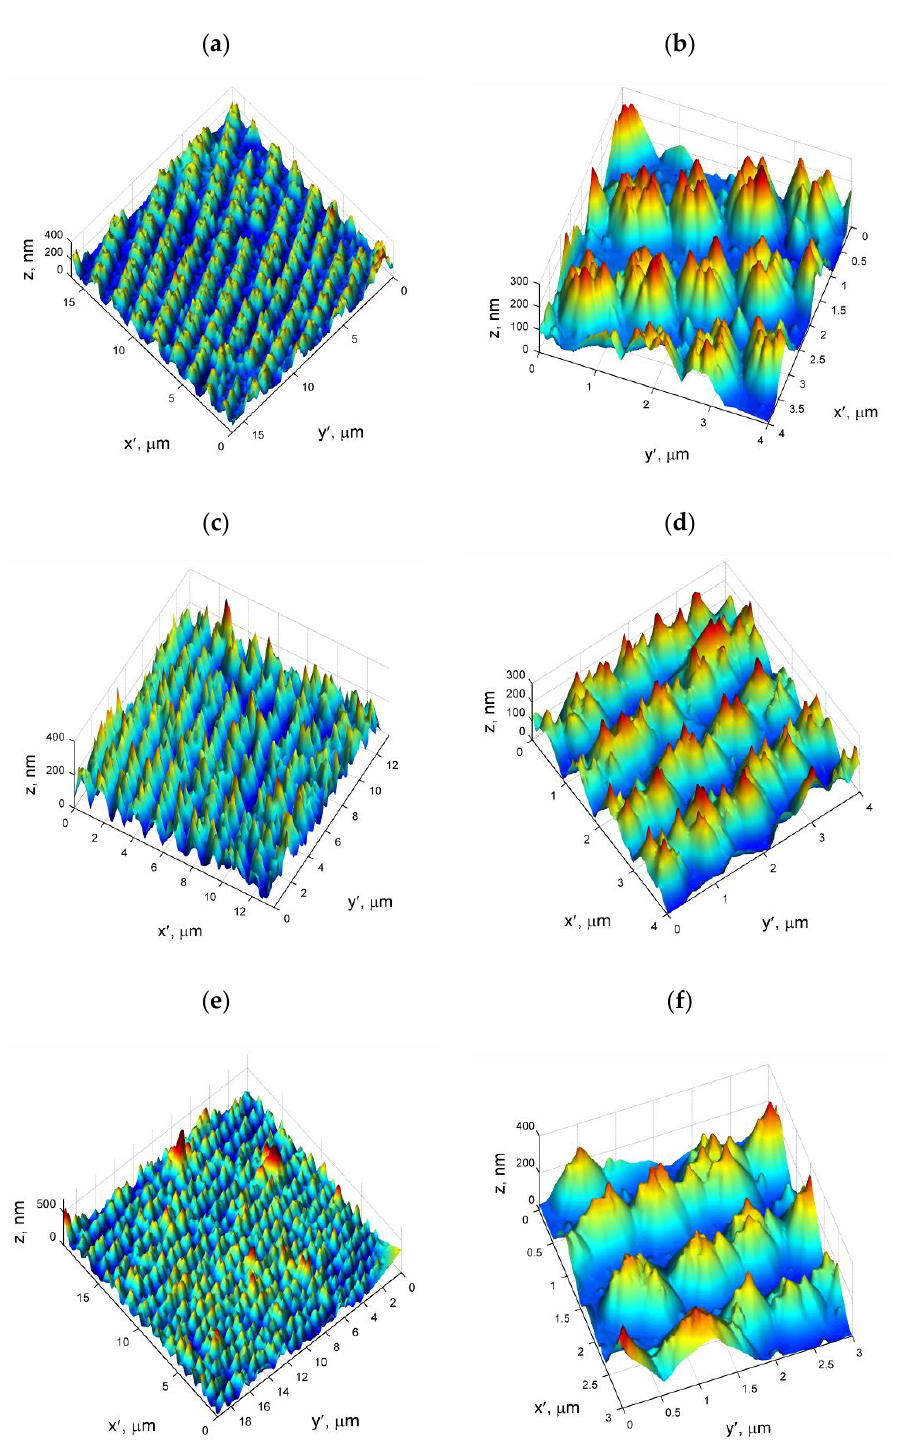
Figure 6. AFM images for patterns with squares arranged according to Scheme B. Above— H = 1 µ m and h y = 1.2 µ m ( U = 5 kV and D = 5000 µ C/cm 2 ), in the middle— H = 0.25 µ m and h y = 0.4 µ m ( U = 5 kV and D = 5000 µ C/cm 2 ), below— H = 0.25 µ m and h y = 0.8 µ m ( U = 10 kV and D = 20,000 µ C/cm 2 ). ( a , c , e ) — Large area scan results. ( b , d , f ) — Scan results on smaller areas. Experiments demonstrated that in the case of squares with H = 1 µm, when h y de- creases from the initial 2 µm to 1.2–1.3 µm (η = 0.2–0.3 µm), the lower parts of fairly large